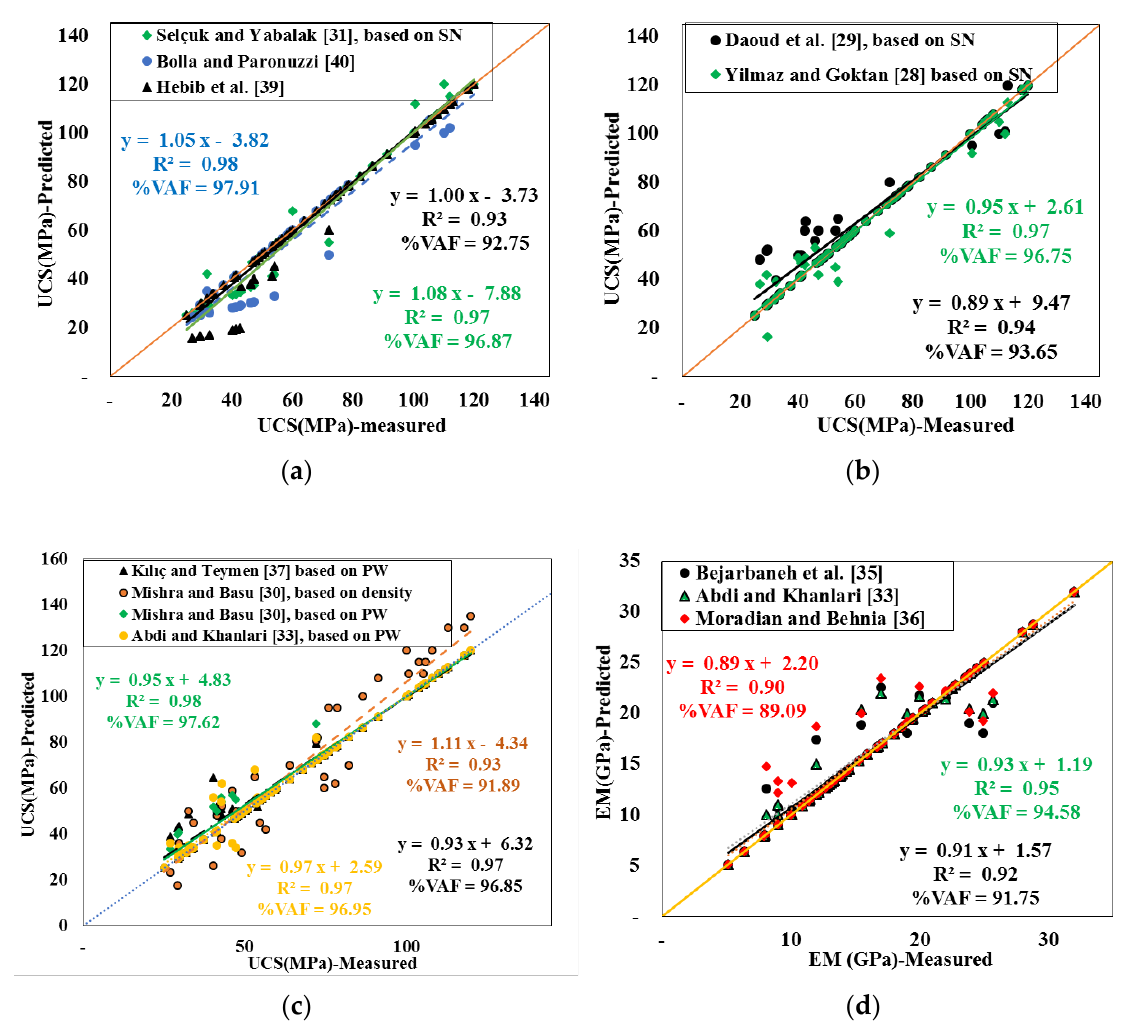
Figure 3. Evaluation of experimental relationship to estimate UCS and EM with laboratory data: ( a ), ( b ), and ( c ) for UCS prediction, and ( d ) for EM prediction [33,35,36]. Table 5. Parameters of the developed SVR model to estimate UCS and EM. UCS EM Train data 75% of whole data 75% of whole data Test data 25% of whole data 25% of whole data Epsilon 0.0022 0.0016 Gamma 0.90